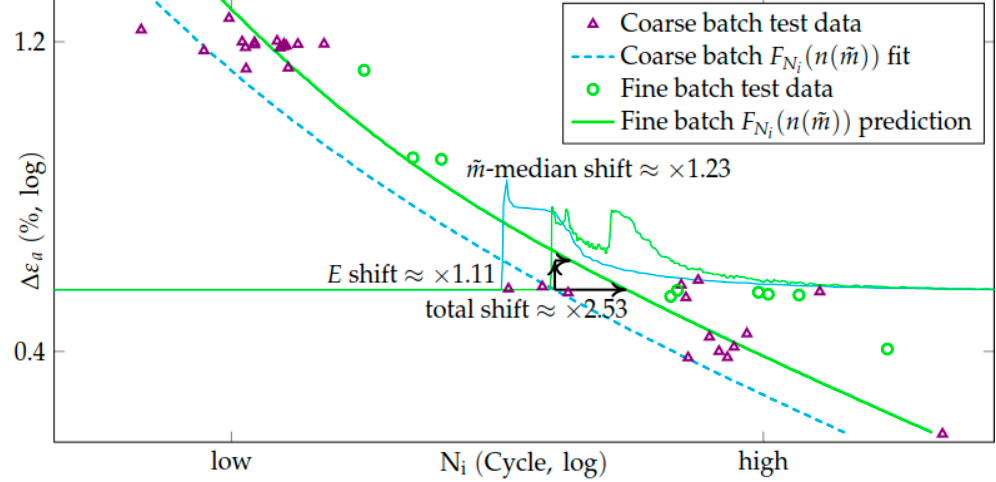
Figure 15. Fit and prediction curve for the CMB with single grain Schmid factor distribution model.